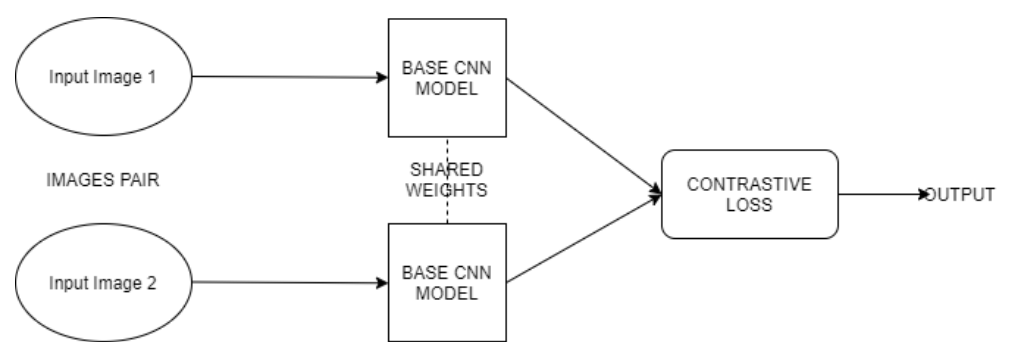
Figure 6. Outline of the Siamese network model used in the current